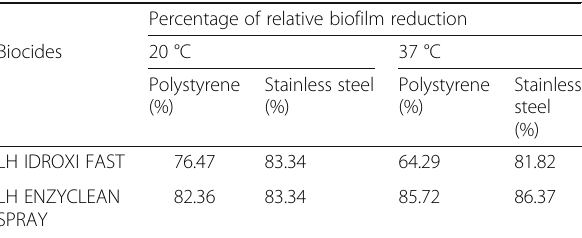
Table 2 In vitro antibiofilm action of biocides on E. hirae ATCC 10541 grown on polystyrene and stainless steel, expressed as relative reduction (%) of biofilm biomass in respect to the untreated sample (control), after 60 min of contact at 20 and 37 °C. The biocides were used at concentration recommended by